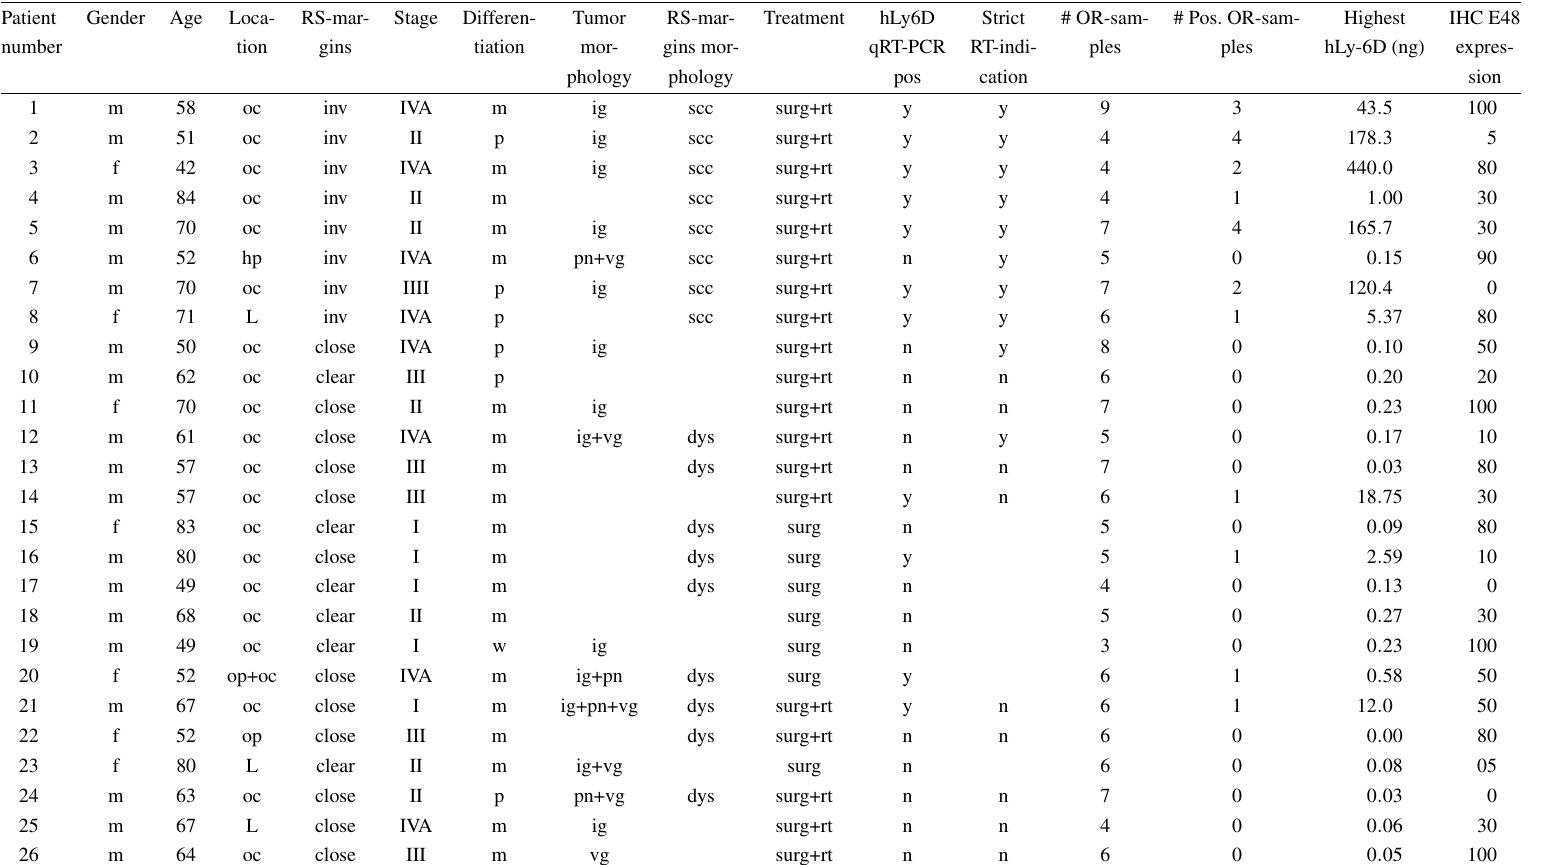
Characteristics of the HNSCC patients and molecular